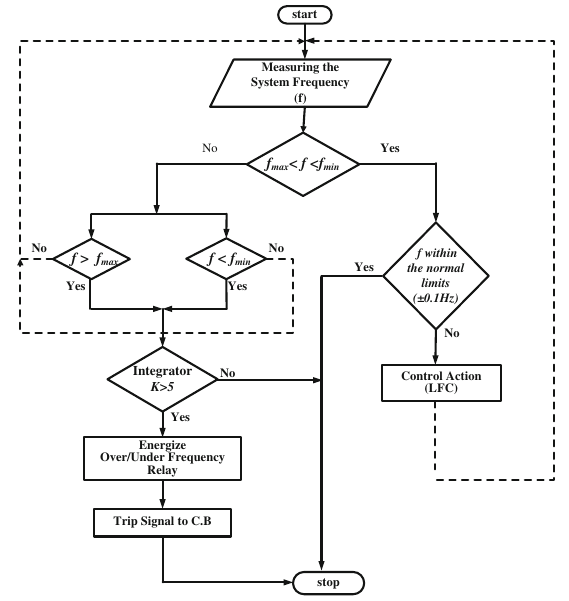
Fig. 7 Flowchart of the proposed coordination